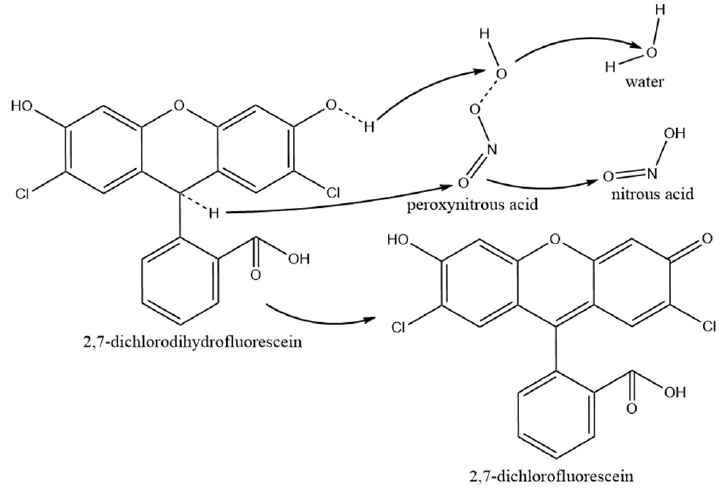
Figure 8. Pathways for the oxidation of 2,7-dichlorodihydrofluorescein (DCFH) by ONOOH. The homolysis of ONOOH into OH and NO 2 radicals leads to the oxidation of DCFH into 2,7-dichloro- fluorescein.